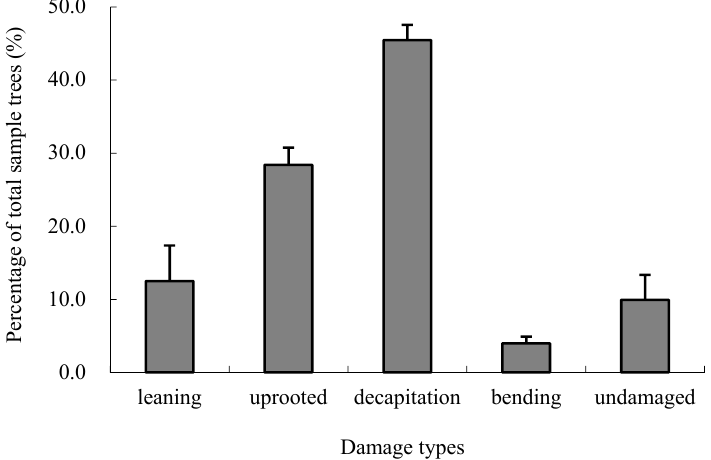
Figure 2. The distribution percentage of five damage types for S. superba total damaged trees in six sample plots following the 2008 ice storm.